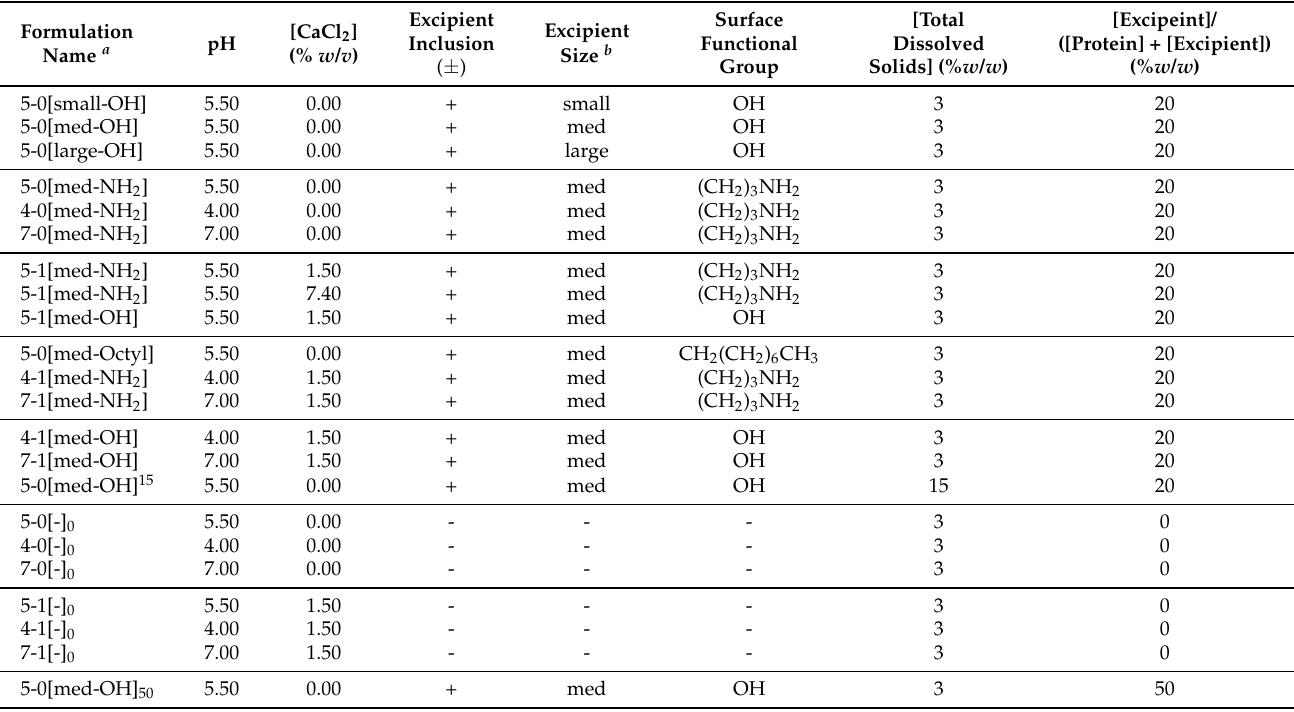
Table 1. Feed solution